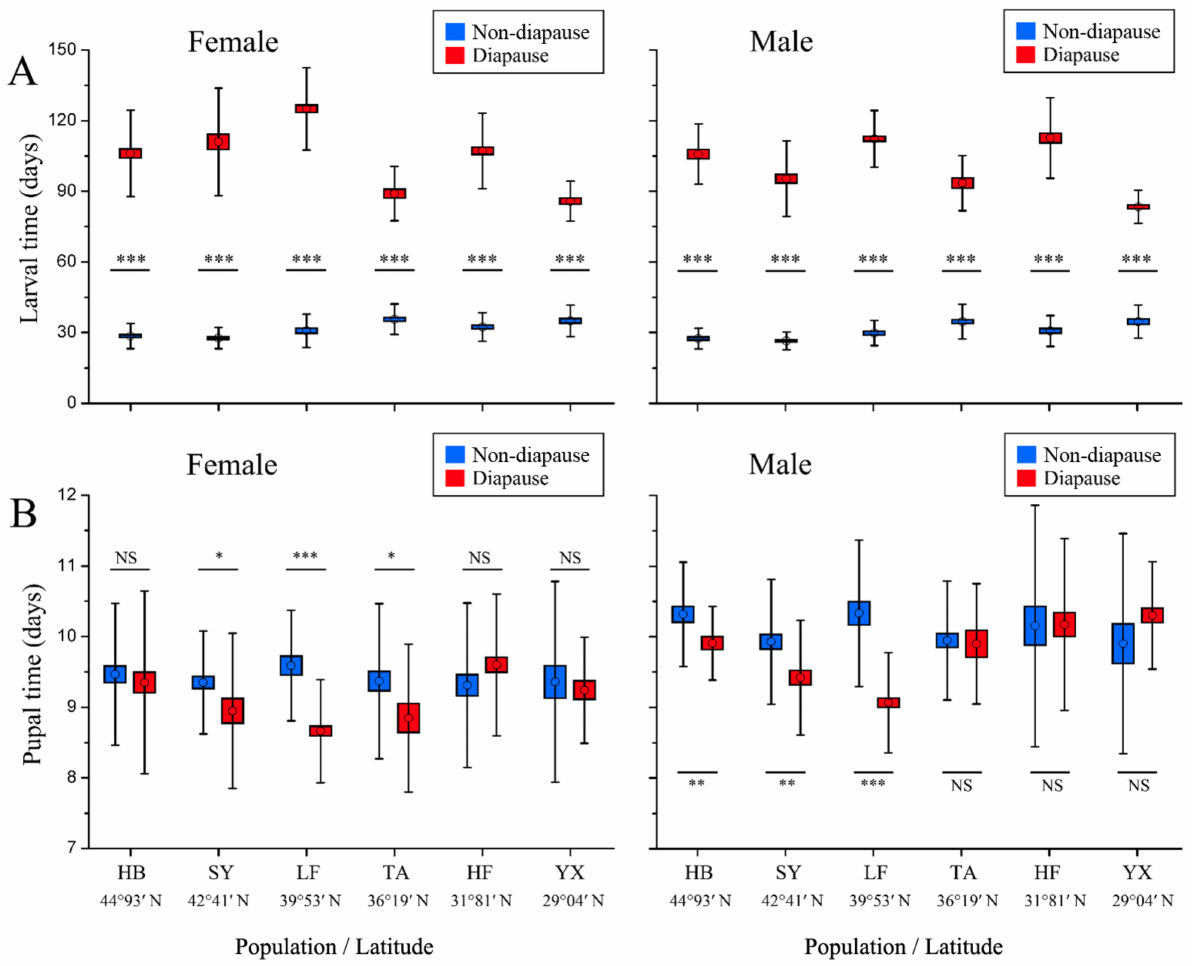
Figure 2. Larval ( A ) and pupal ( B ) developmental time for non-diapausing and diapausing individu- als in different geographical populations of Ostrinia furnacalis . The asterisk indicates a significant dif- ference between non-diapausing and diapausing individuals in each subgraph (* p ≤ 0.05, ** p ≤ 0.01, *** p ≤ 0.00). NS = Nonsignificant. Error bars indicate